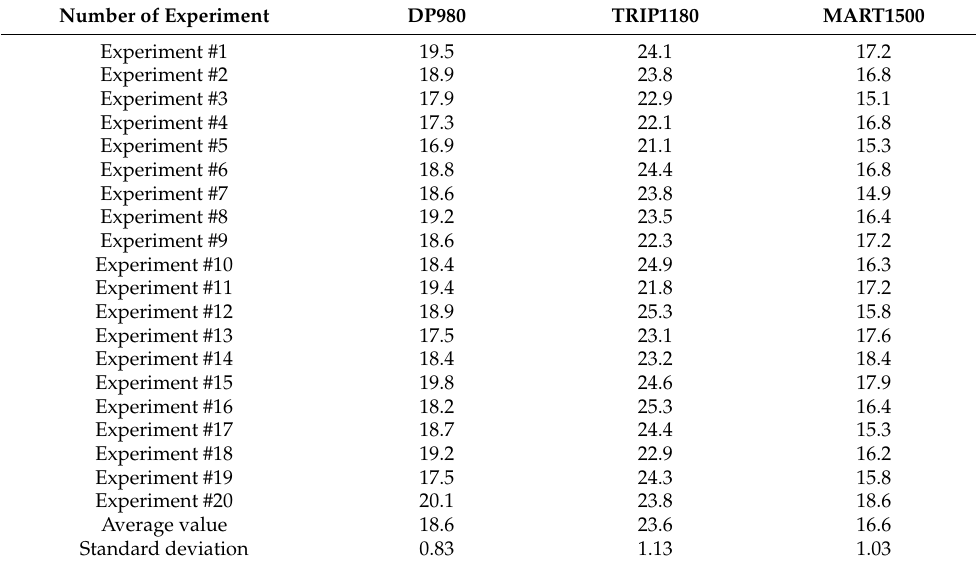
Table 2. Measured HER by utilizing machine vision system.